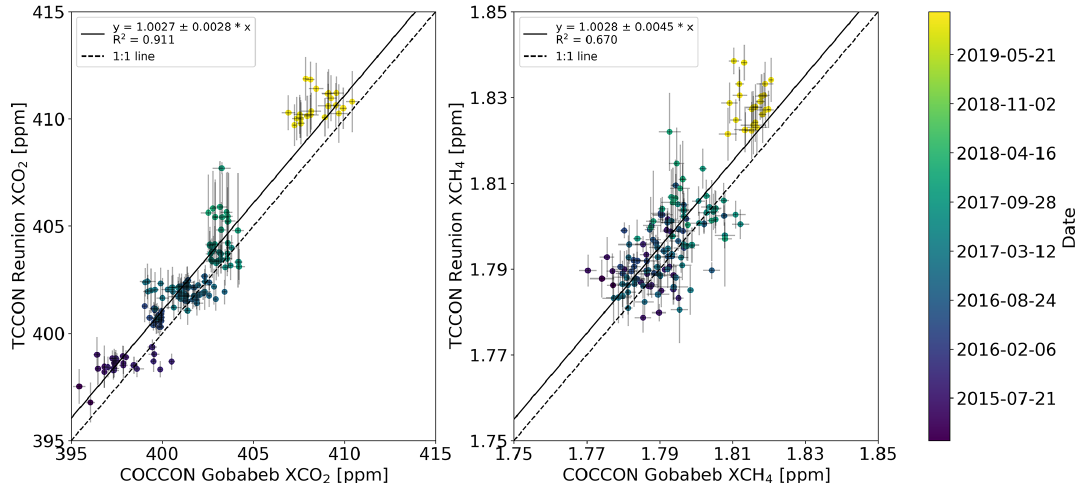
Figure 7. Correlation plots between the COCCON Gobabeb and TCCON Réunion Island stations for XCO 2 and XCH 4 from 2015 to 2019. Shown are daily mean values; error bars denote the 1 σ standard deviation. The color bar denotes the date of the